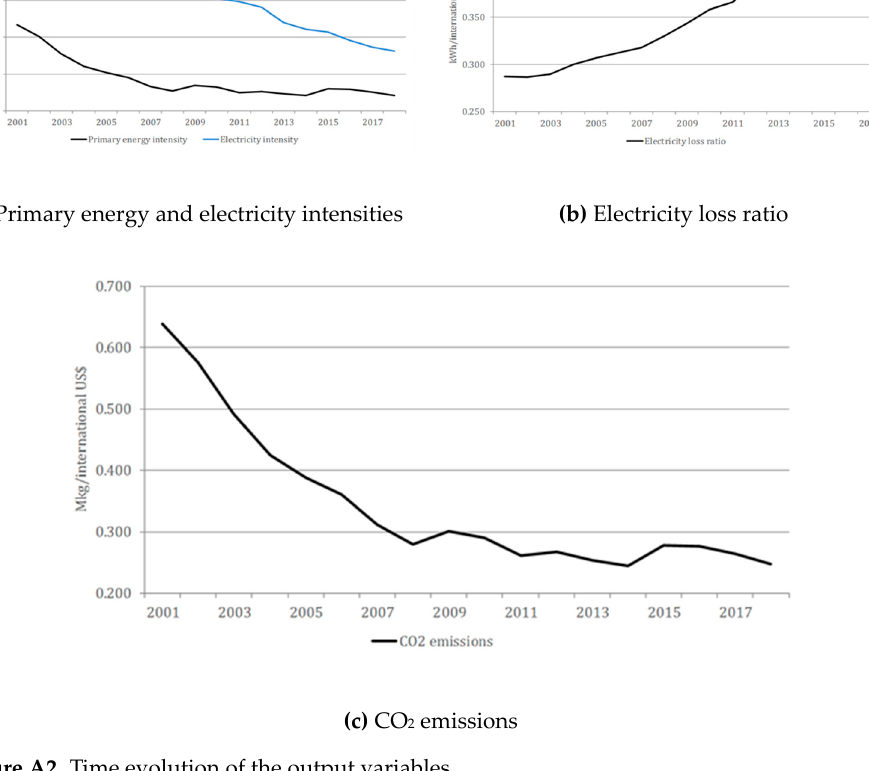
Figure A4. Electricity intensity and nominal GDP per capita.